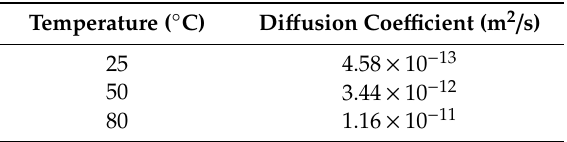
Table 1. Di ff usion coe ffi cient of polypropylene-toluene.